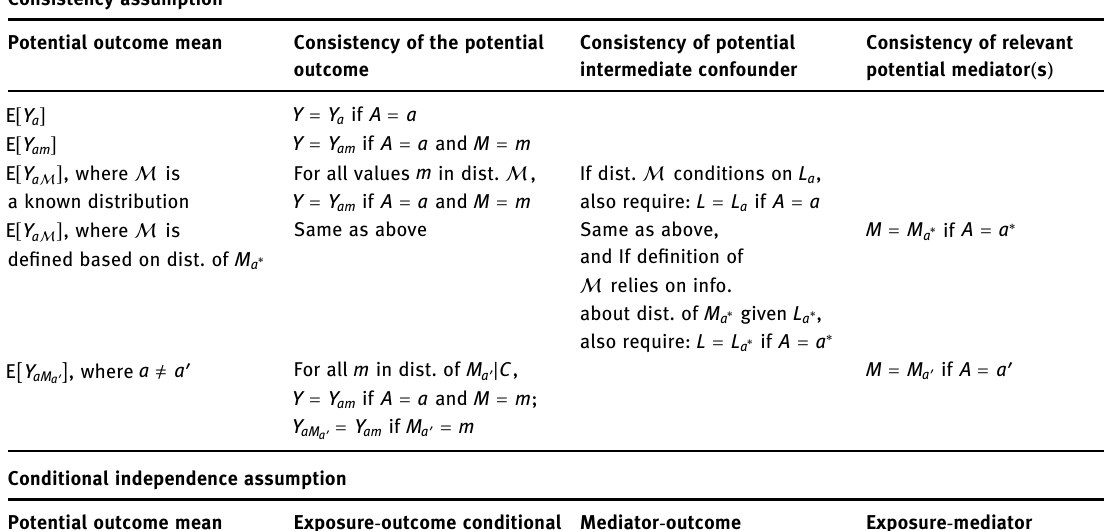
Table 1: Three identifying assumptions for fi ve potential outcome means Consistency